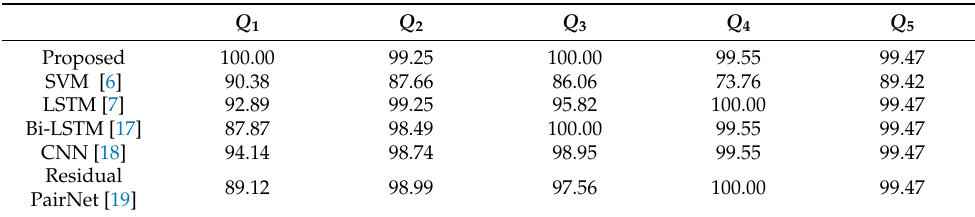
Table 5. Classification accuracies (in percentage) of various algorithms, where Q i is the classification accuracy of gesture class i . We define Q i as the number of gestures in class i that are correctly classified divided by the total number of gestures in class i